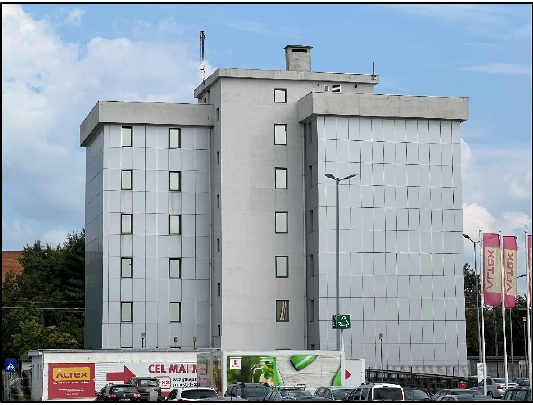
Figure 8. The Headquarter of FED Lugoj (photo taken by author, July 2022).